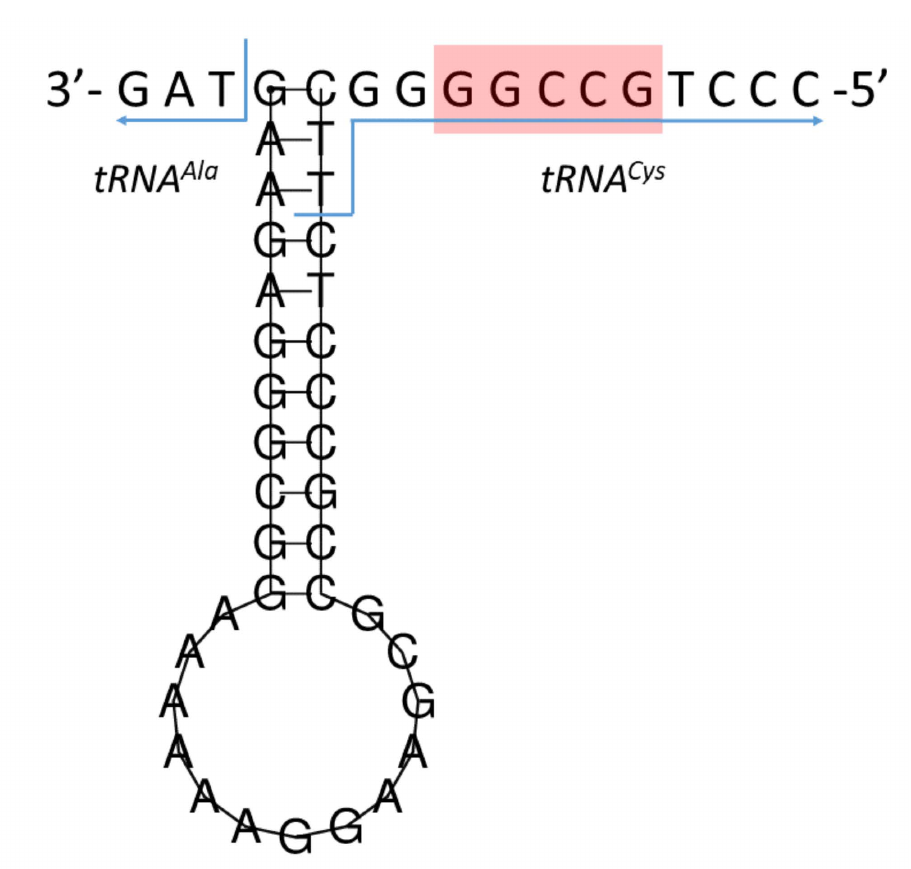
Figure 6. Predicted secondary structure of the L-strand replication origin (the 5 (cid:48) -GCCGG-3 (cid:48) conserved motif indicated by a red